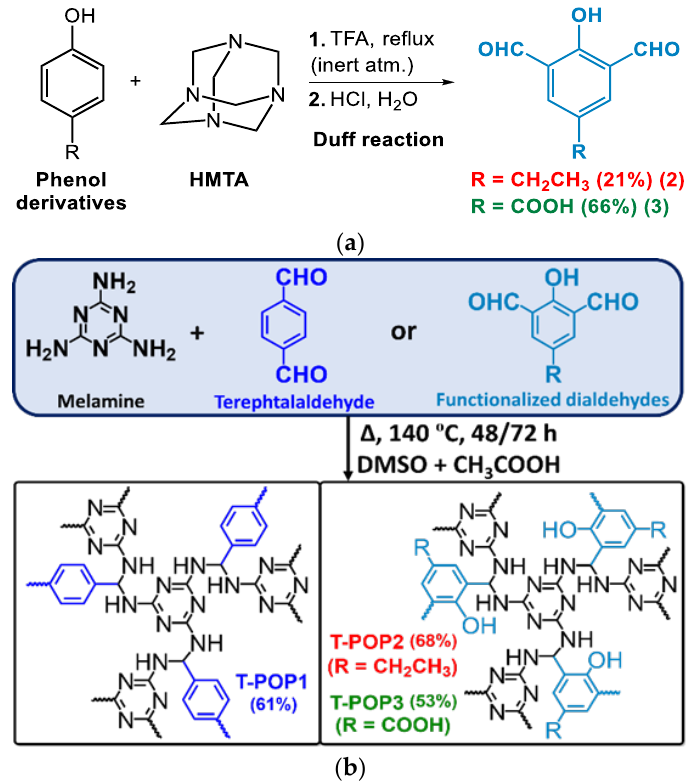
Figure 1. ( a ) Duff reaction to obtain functionalized dialdehydes; ( b ) polycondensation reaction between melamine and a dialdehyde to obtain T-POPs.